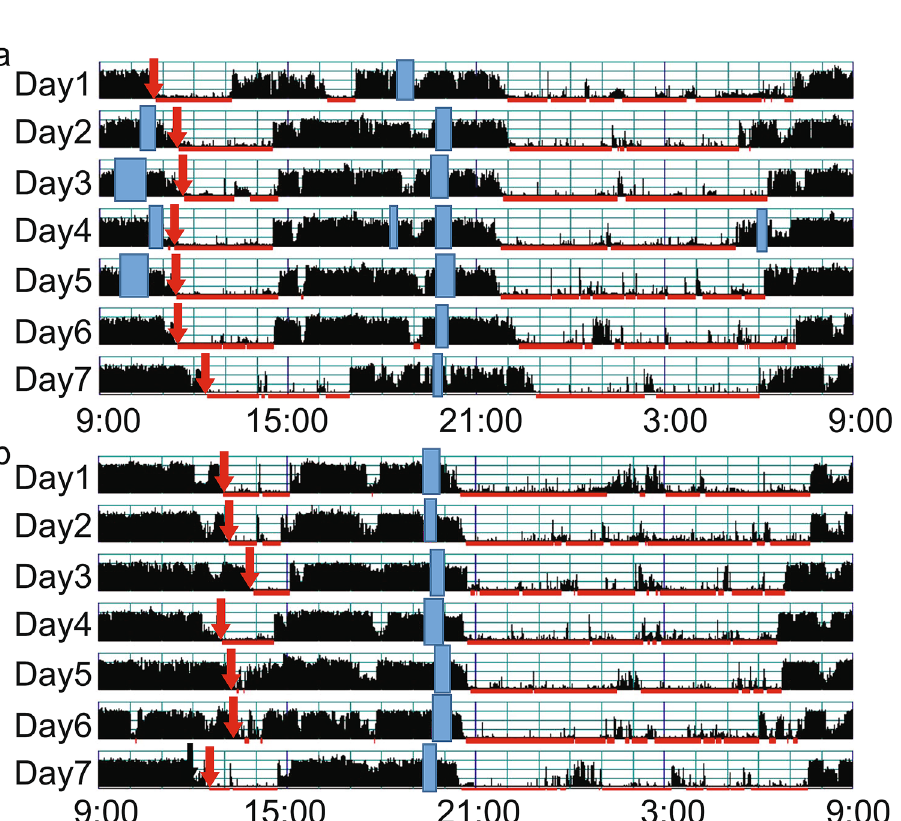
Figure 1. The actograms show representative daily activity-rest patterns of toddlers of approximately 1.5 years of age with early nap onset times and long nap duration ( a ) and late nap onset times and short nap duration ( b ). The vertical axis shows the 7 consecutive observation days and the horizontal axis shows the course of each 24 h day from 9:00 h (9:00 am). Activity counts per minute are represented by the height of the vertical black bars on each actogram. The red arrows and the blue rectangles indicate naps and bathing periods, respectively. The red underlines are the periods that were automatically judged as sleep periods by the actigraph software. Note that the nap onset times are recognized as relatively early in ( a ) but as late in ( b